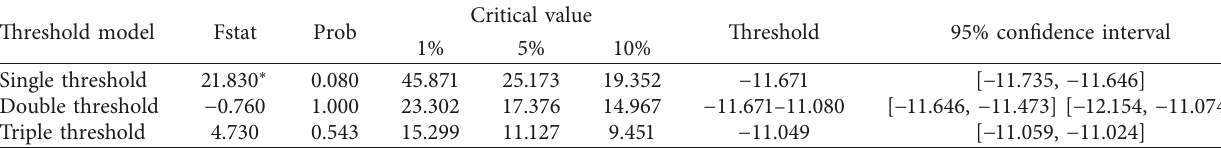
Table 5: Threshold effect significance results of technology intensity.